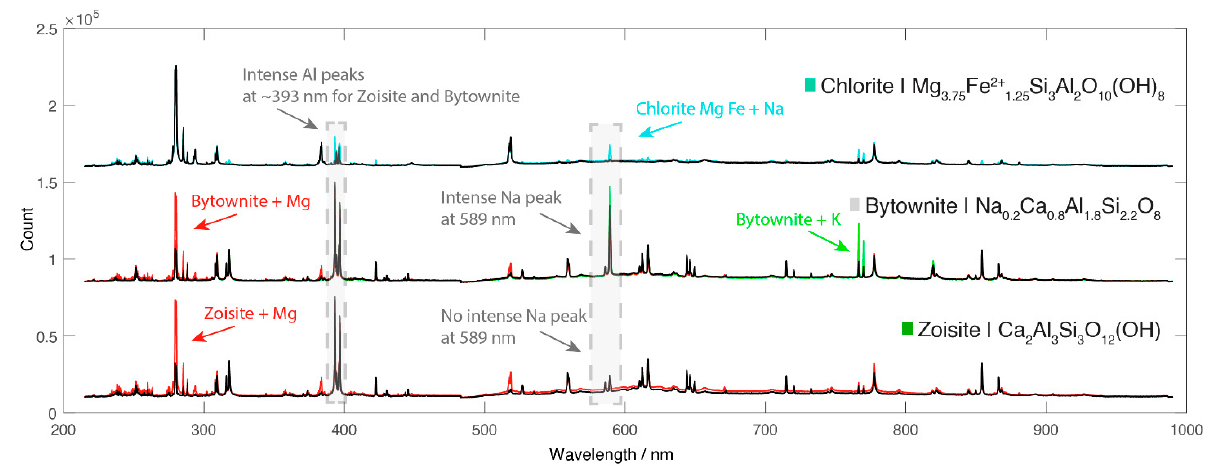
Figure 4. Full spectra of chlorite and chlorite Mg Fe + Na, bytownite, bytownite + Mg and bytownite + K and zoisite and zoisite + Mg assigned mineralogies.